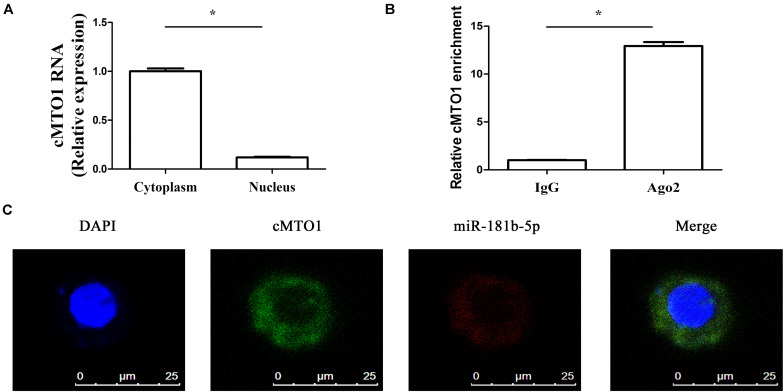
cMTO1 could bind to miRNAs. (A) The distribution of cMTO1 in cytoplasm and nucleus of HSCs. (B) RIP experiments were performed using Ago2 antibody on extracts from primary HSCs. Relative level of cMTO1 was expressed as fold enrichment in Ago2 relative to IgG immunoprecipitates by qRT-PCR. (C) Co-localization between miR-181b-5p and cMTO1 was observed by RNA in situ hybridization. *P < 0.05. Each value is the mean ± SD of three experiments.